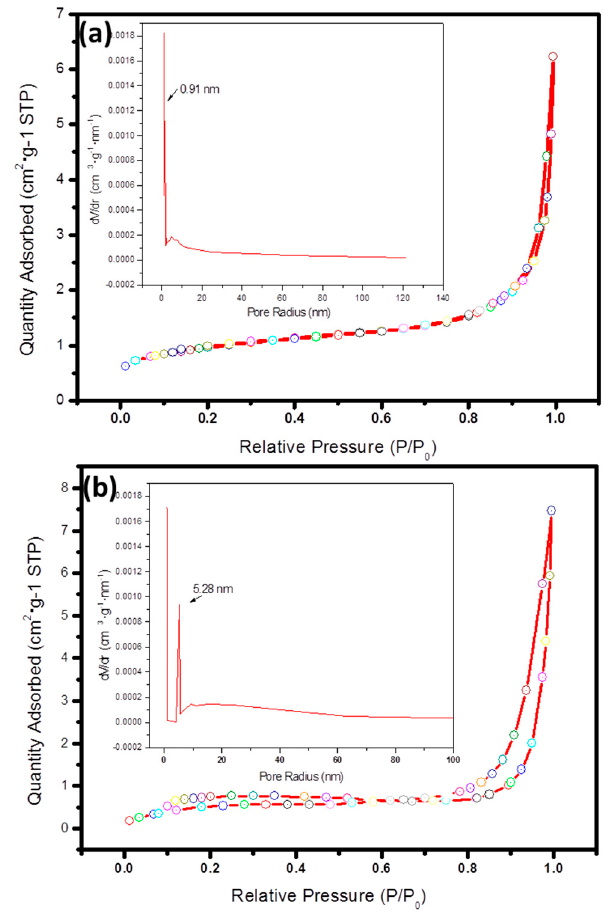
Figure 4. N 2 adsorption–desorption isotherm of ( a ) β -Bi 2 O 3 and ( b ) β -Bi 2 O 3 /GN (1%). Inset: the corresponding pore size distribution.